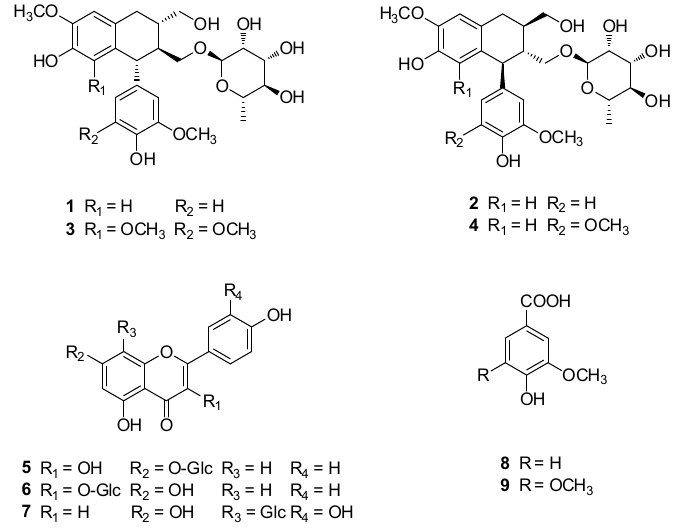
Figure 2. Chemical structures of compounds 1 – 9 .